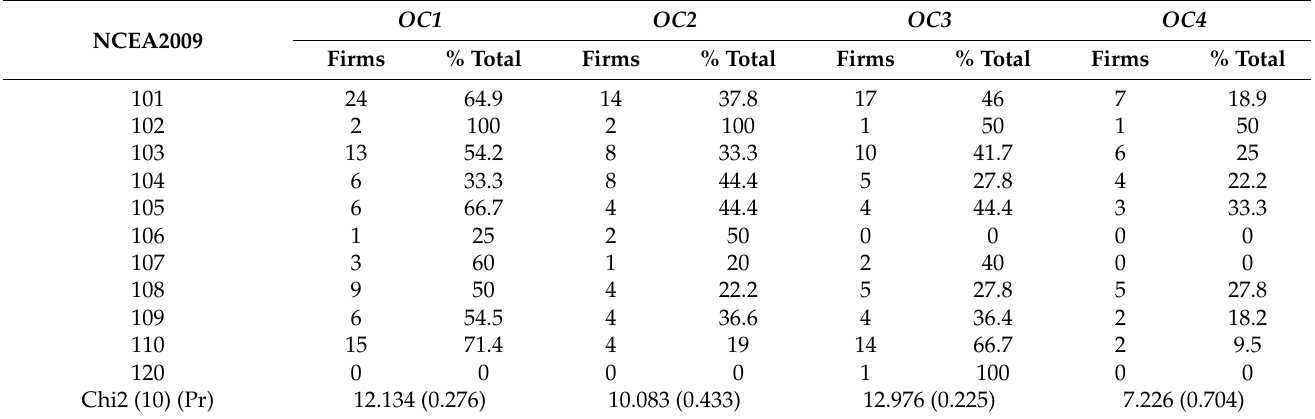
Table 4. Negative consequences affecting the operating function according to the branch of